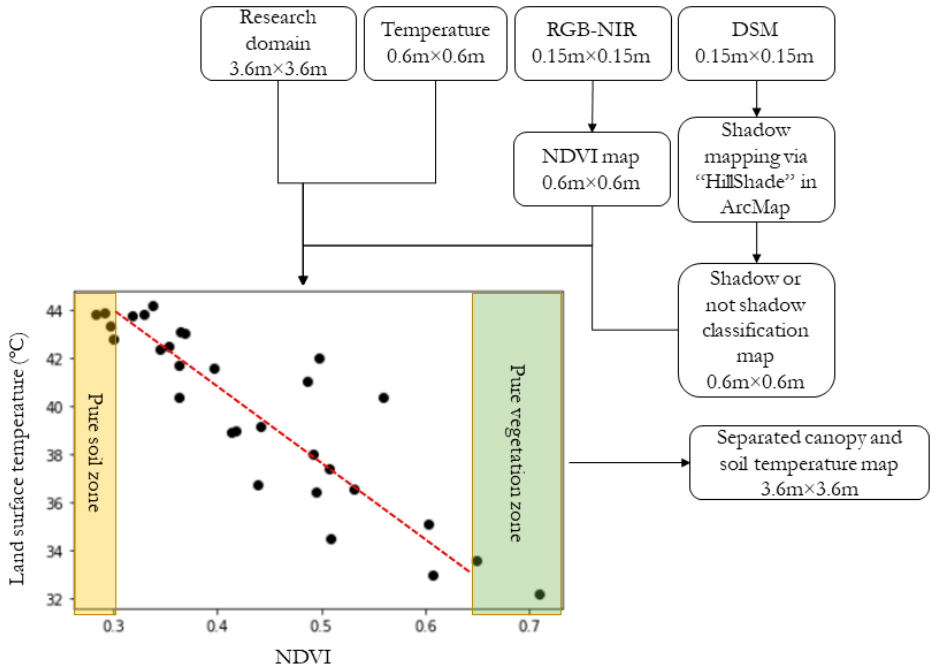
Figure 3. Flowchart showing the ideal temperature separation process for a single TSEB model pixel (3.6 m resolution). (3.6 m